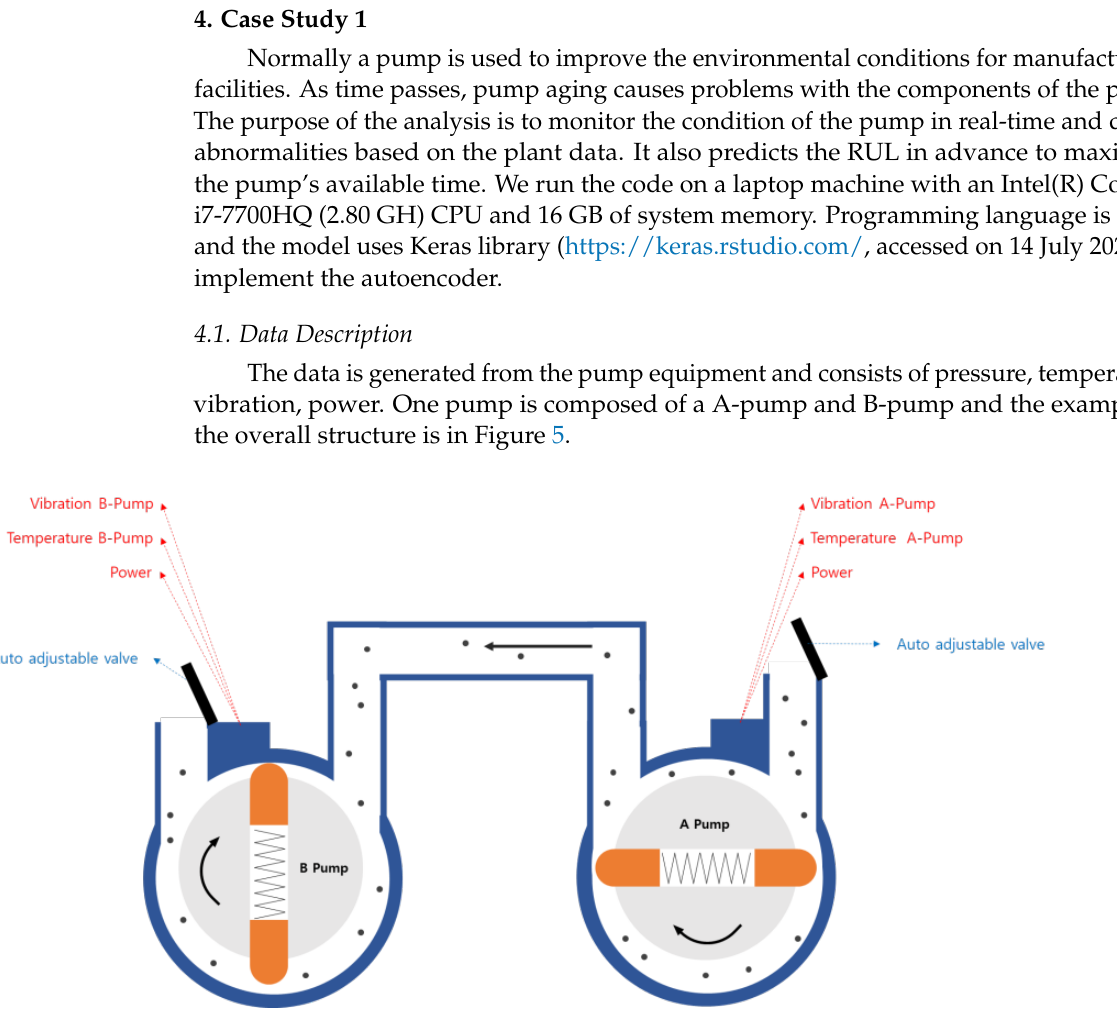
Figure 4. The example of the Health Index and the RUL prediction difference. ( a ) fitting results of the last 50 samples; ( b ) fitting results of the total samples.